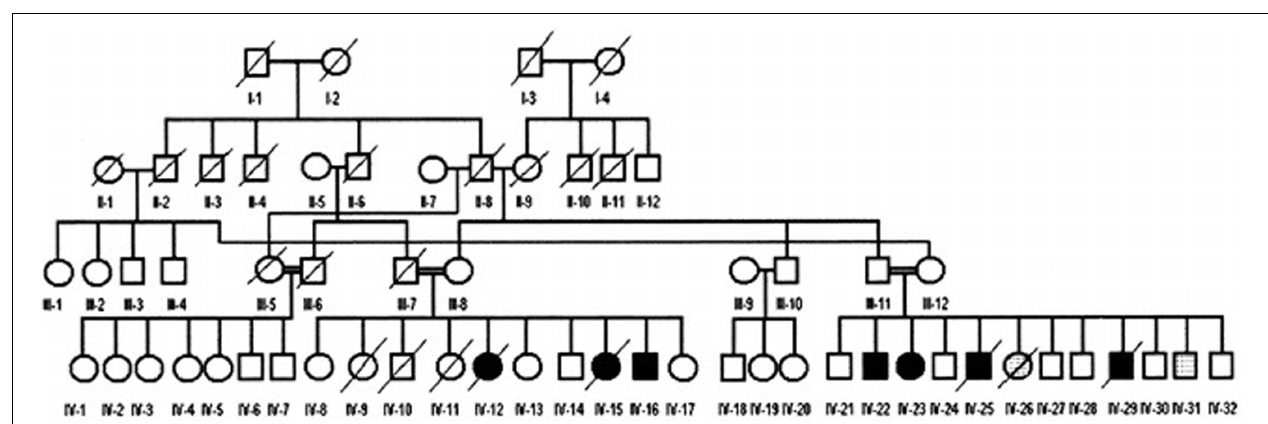
marriages; diagonal lines represent deceased persons; roman numerals: generations; Arabic numerals: birth order of siblings. A specific combination of numerals, like IV-16, uniquely identifies each